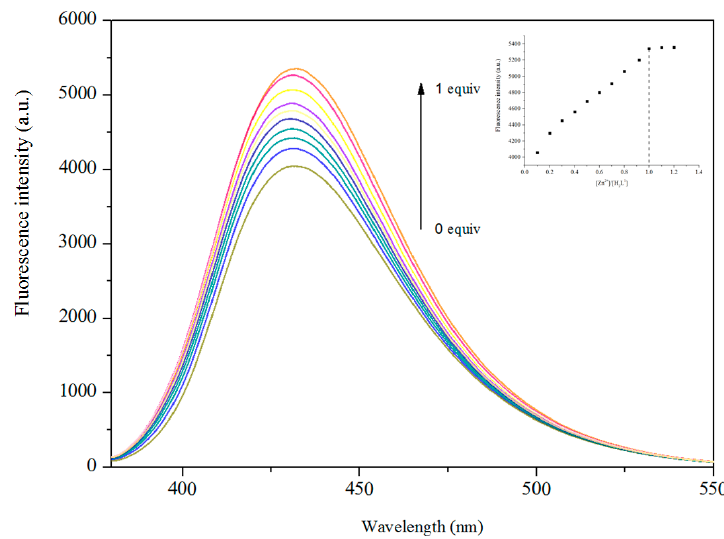
Figure 8. Absorption spectra of H 2 L 1 in DMF solution upon the addition of Zn 2+ . Inset: The absorbance at 432 nm varied as an interaction of [Zn 2+ ]/[H 2 L 1 ].